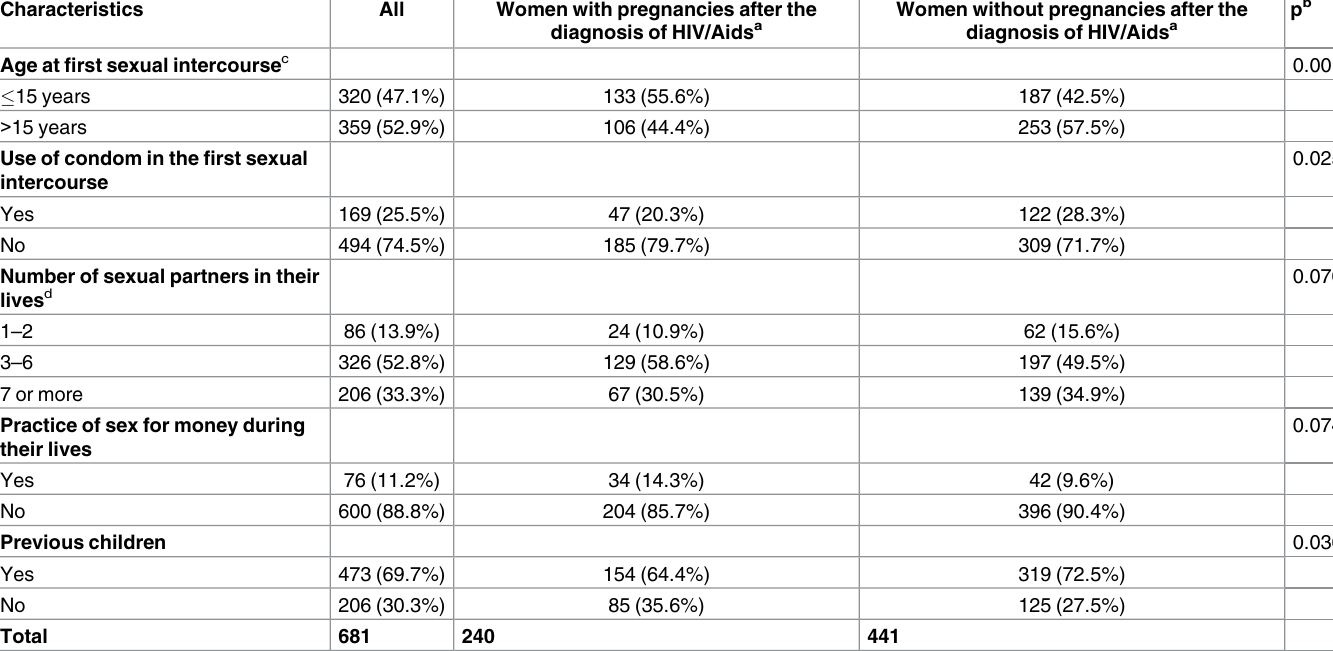
Table 2. Sexual and reproductive behavior of women living with HIV, in accordancewith the occurrence of pregnancies after diagnosis, in Porto Alegre, 2011. Characteristics All Women with pregnancies after the